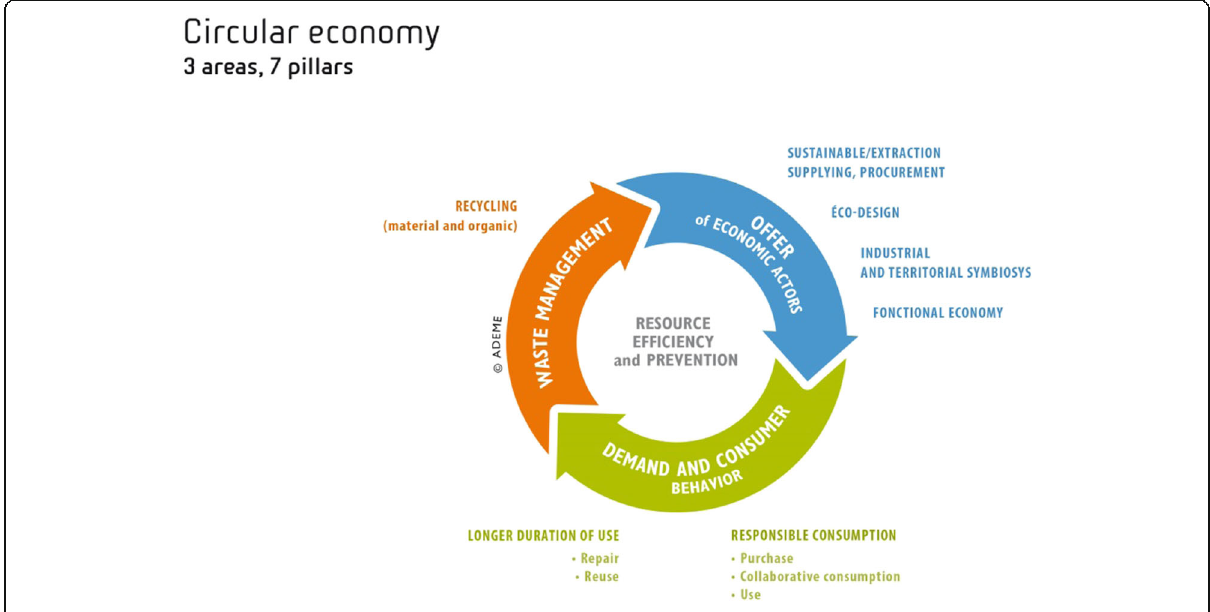
Fig. 1 The principles of a circular economy according to Ademe